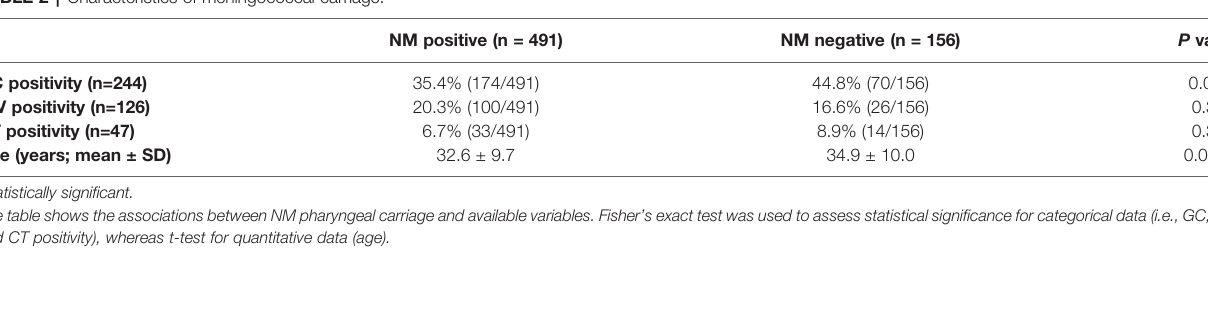
TABLE 2 | Characteristics of meningococcal